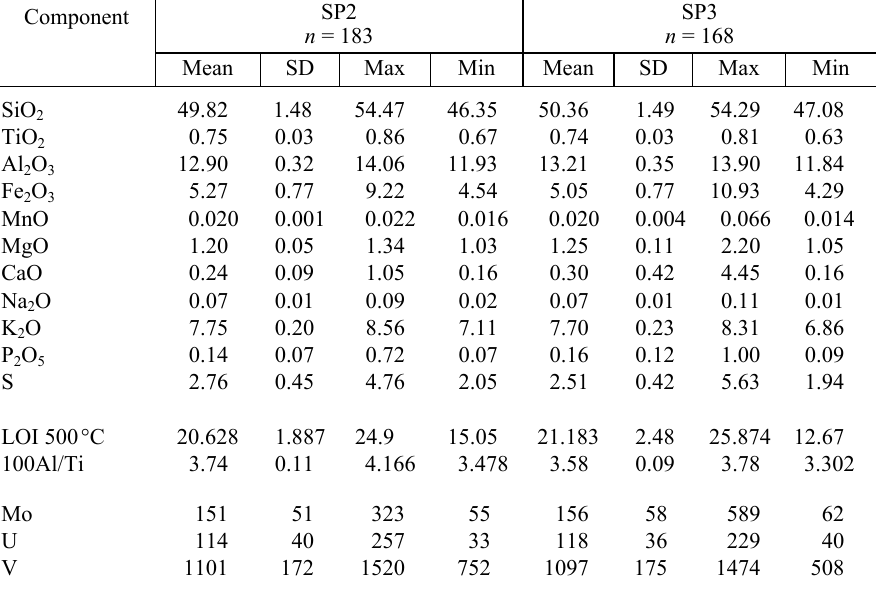
Table 1. Summarized results of XRF analyses of major elements (wt%) and redox-sensitive elements (ppm), recorded loss on ignition values (wt%) and calculated Ti/Al molar ratios of the black shales of the T(cid:252)risalu Fm. from SP2 and SP3 drill cores SP2 n =